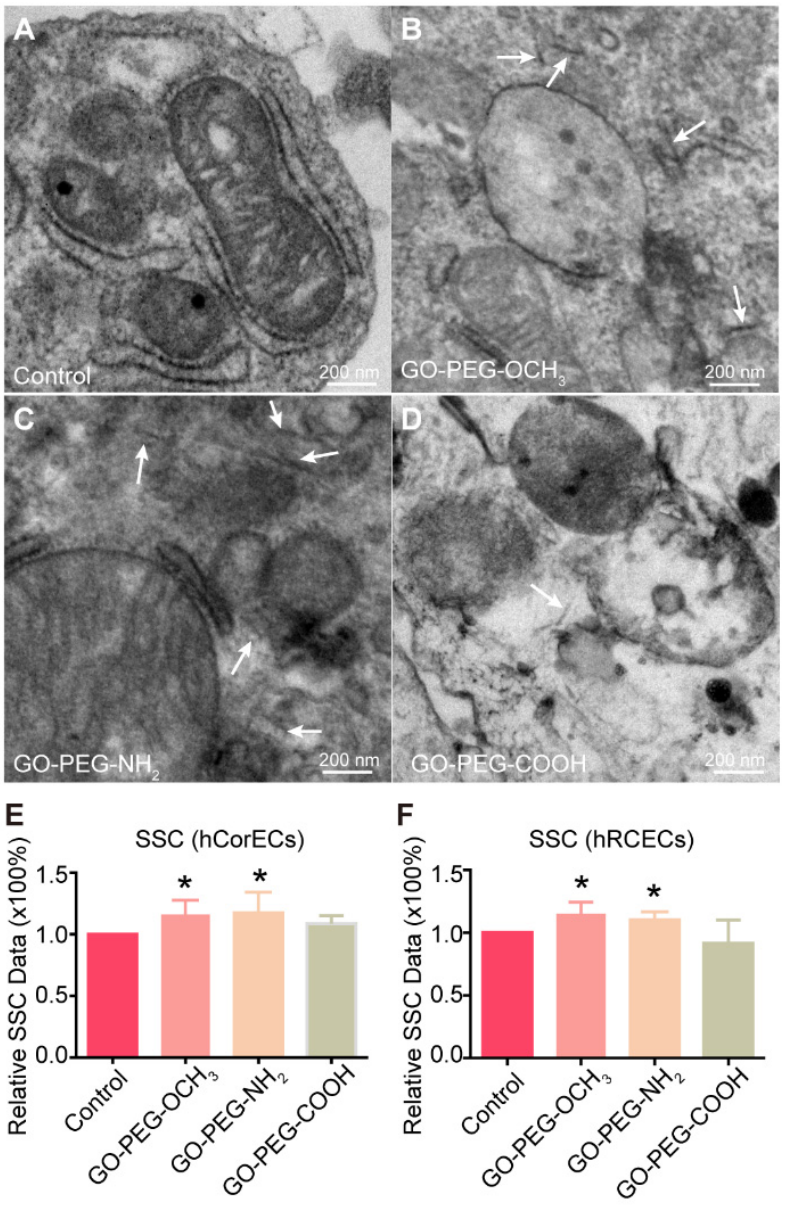
Figure 1. Cellular uptake of PEGylated graphene oxide (PEG-GO) nanosheets with different surface charges by human corneal epithelial cells (hCorECs) and human retinal capillary endothelial cells (hRCECs). ( A – D ) The ultrastructure of hCorECs exposed to ( A ) control (0 mg/mL), ( B ) neutrally (GO-PEG-OCH 3 ), ( C ) positively (GO-PEG-NH 2 ) and ( D ) negatively (GO-PEG-COOH) charged PEG- GO samples (50 µ g/mL), respectively. Scale bar = 200 nm. White arrows indicate the internalized PEG-GO nanosheets. ( E , F ) Side scatter (SSC) analysis of ( E ) hCorECs and ( F ) hRCECs treated by PEG-GO nanosheets. Compared with control group: * p < 0.05. Bars show mean ± standard deviation (S.D.). SSC depends on the inner granularity and complexity of the cells.